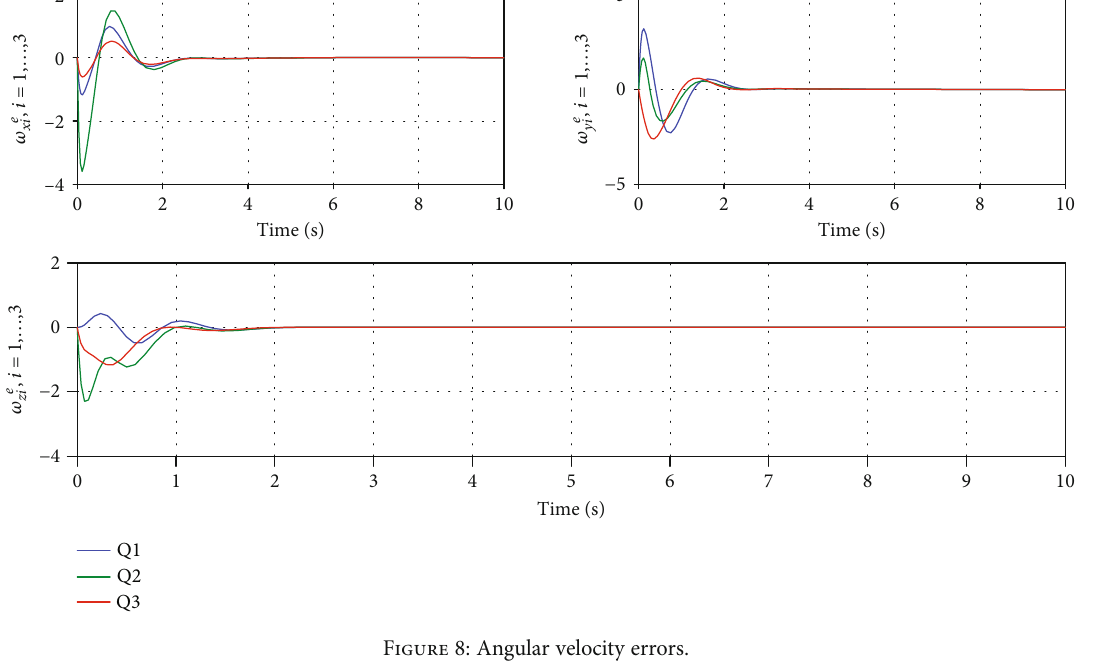
Figure 8: Angular velocity